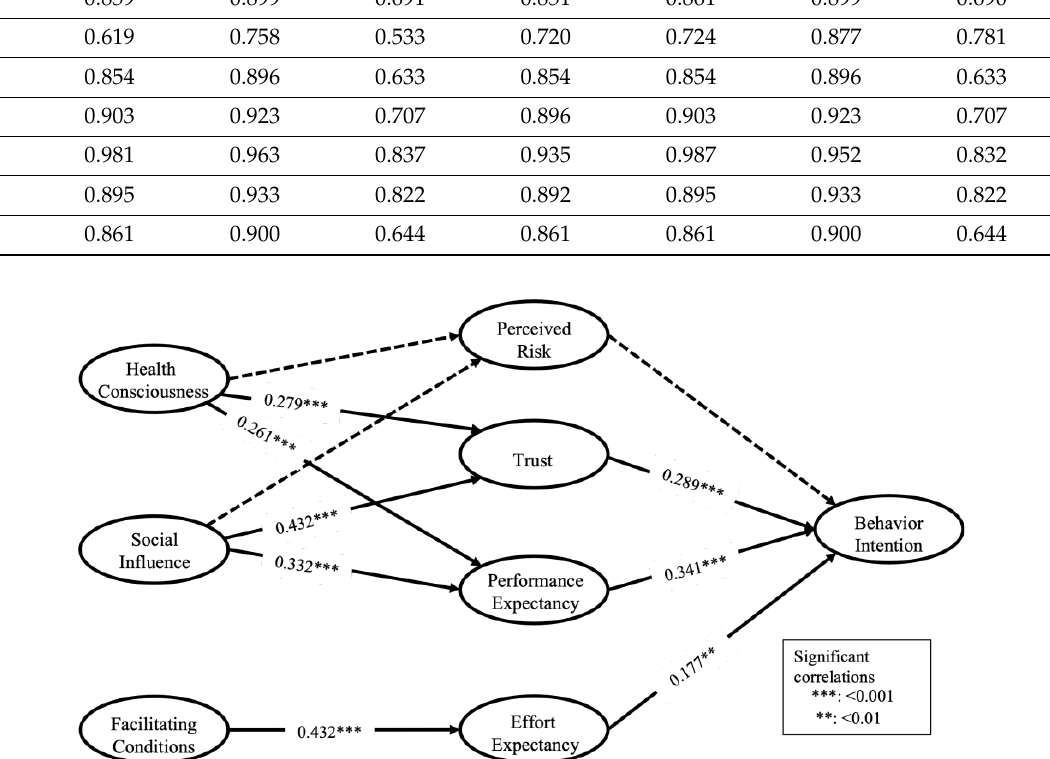
Figure 2. Standardized estimates for the revised model.